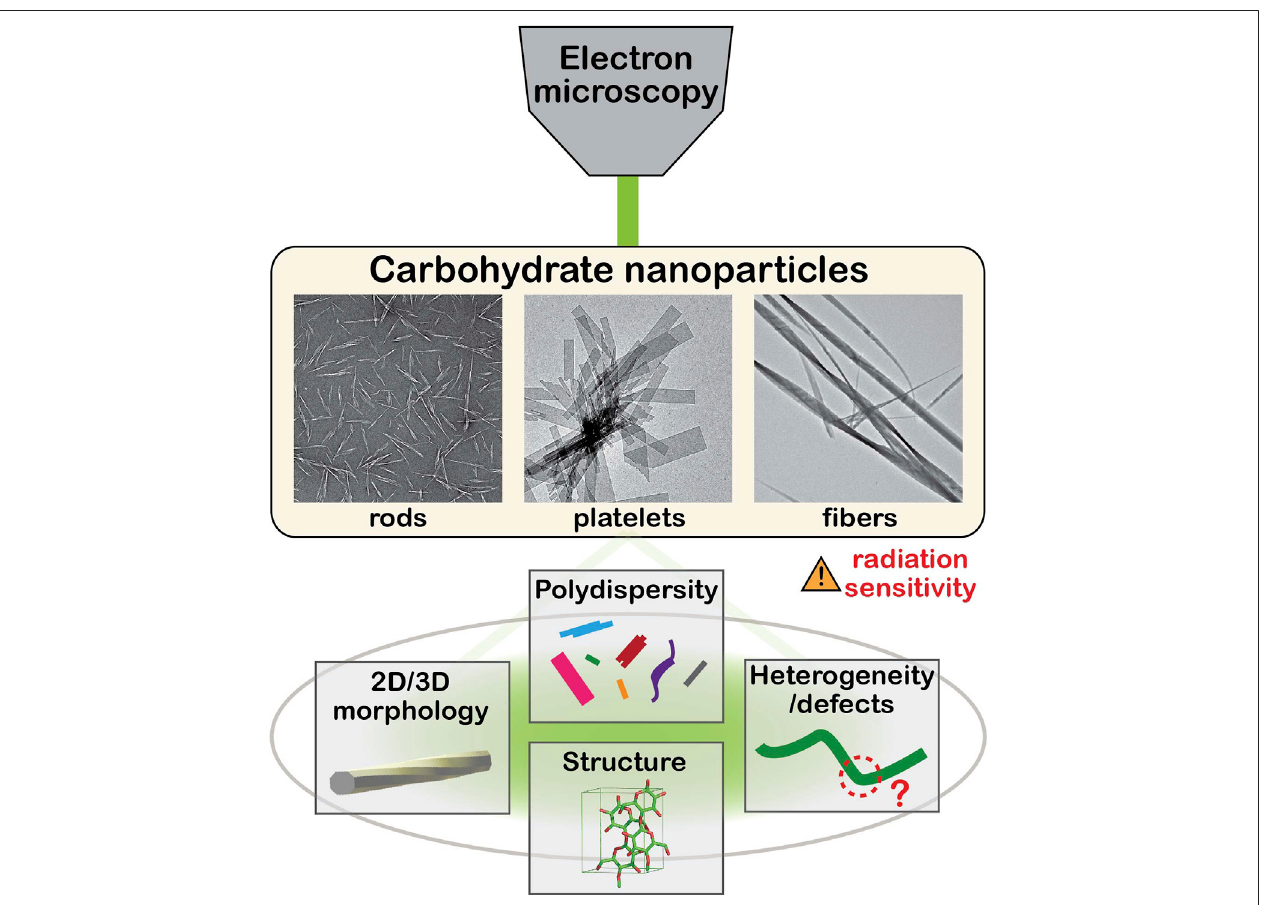
FIGURE 1 | Schematic illustration of electron microscopy of carbohydrate